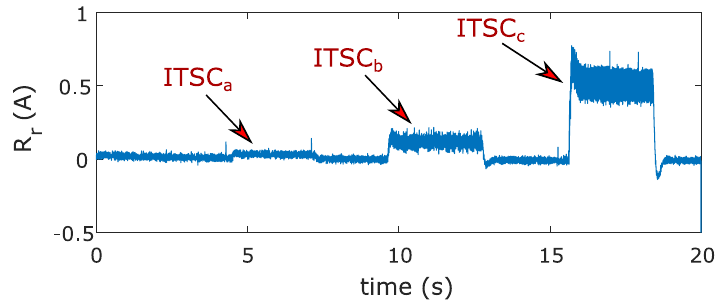
Figure 11. Resultant residual response in an αβ